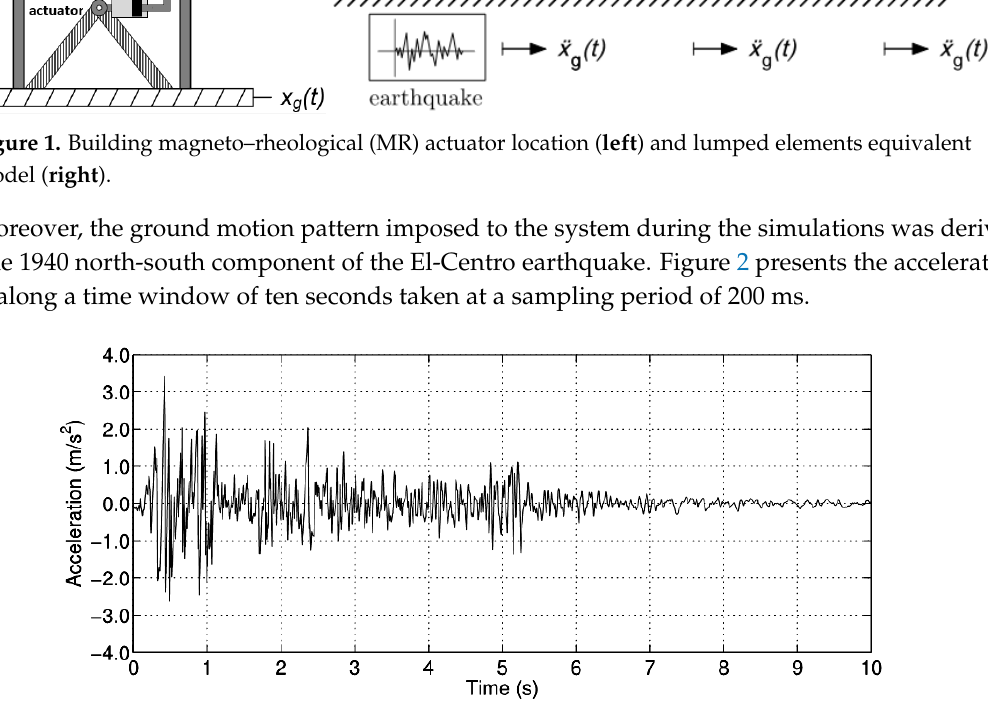
Figure 2. North–south ground motion acceleration component from the El-Centro